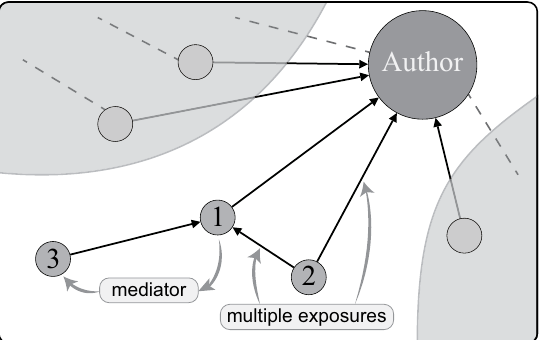
Figure 3. A schematic diagram of direct and indirect retwitters. After the publication of an original tweet from the author, direct followers 1 and 2 will immediately receive the message. Suppose 1 reposts the message, he becomes a direct retwitter. As a consequence, on the one hand, he will be the mediator for his follower 3, a possible indirect retwitter. On the other hand, because of the existence of the direct link from 2 to 1, the retweeting behaviour of retwitter 1 increases the number follower 2 receives the message.